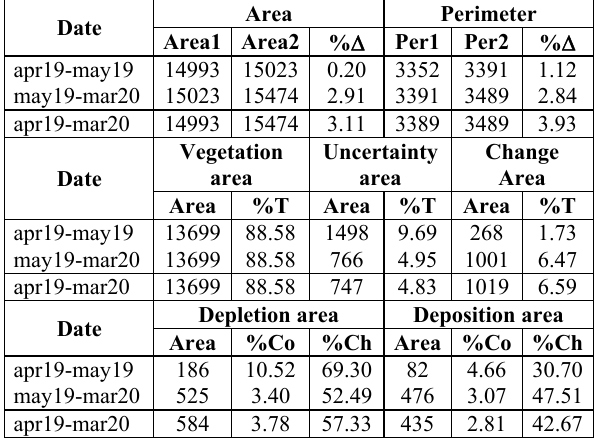
Table 3. Areas affected by the processes in the gully area. Units are in m (perimeter) and m 2 (area).